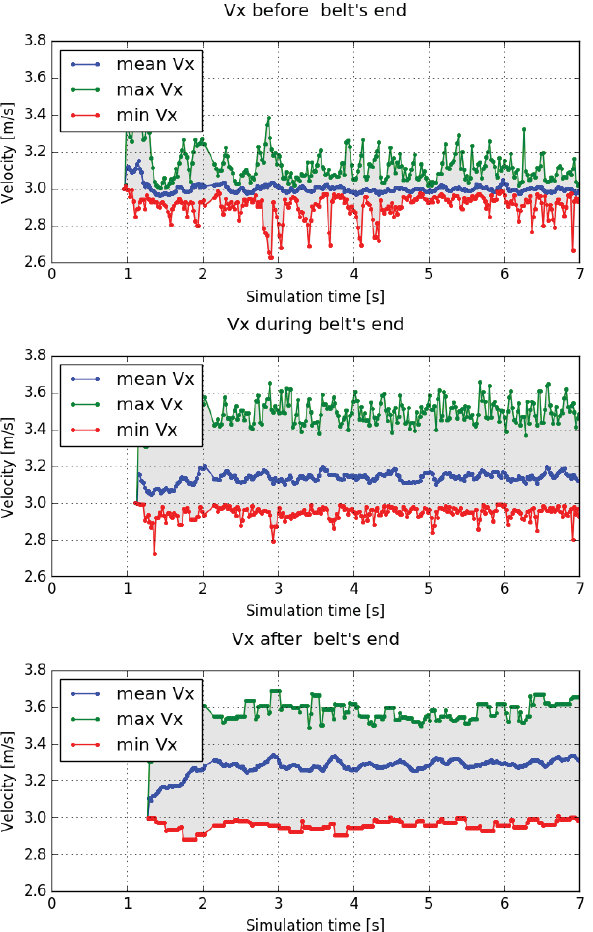
Figure 3. V x max , min , mean for all particles in each region of interest, in a polydisperse system. In this system, we can observe a much higher variability in V x before the endpoint, although the mean value stays around 3.0m / s as expected. Maximum V x af- ter the transition is slightly less than the values obtained for the monodisperse system.